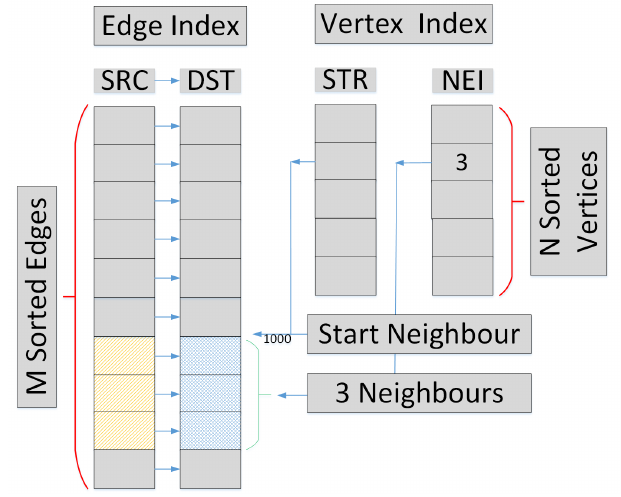
Figure 2. Double Index data structure for graph stream